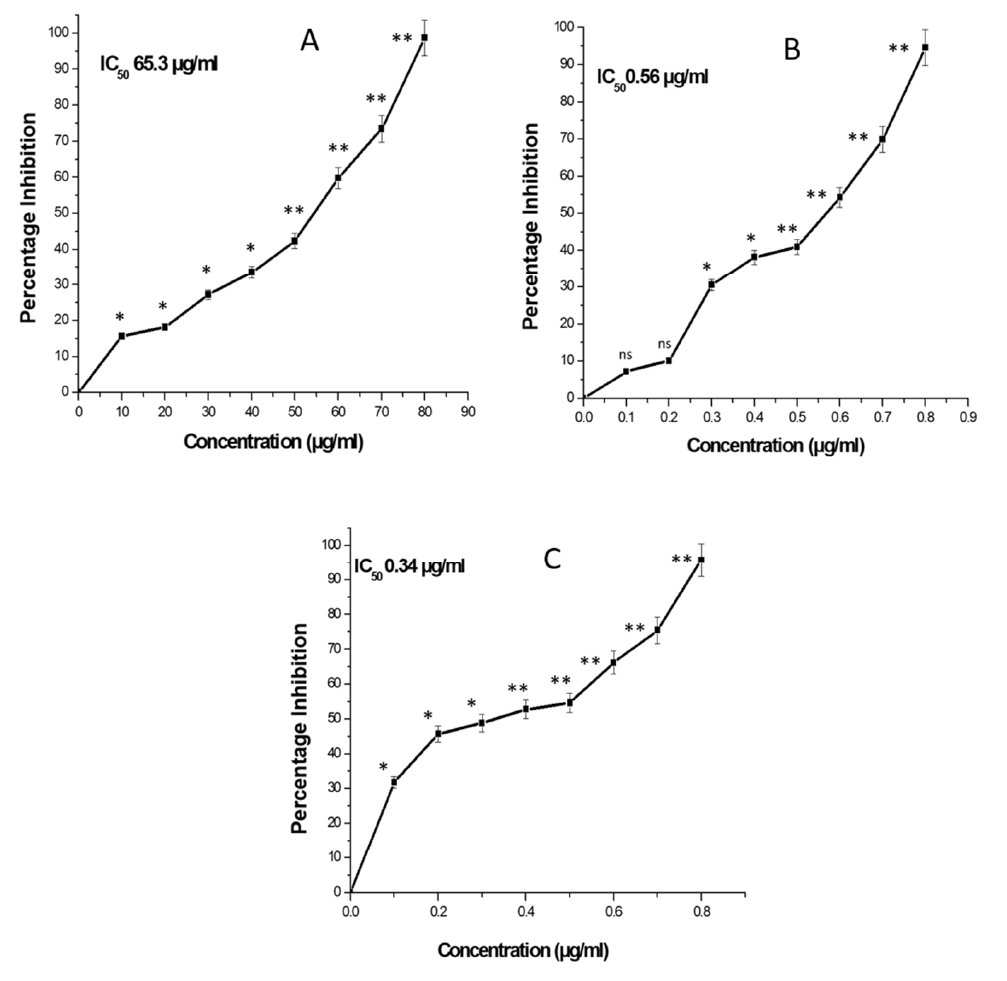
Figure 6. The cytotoxicity study of ( A ) ZnONPs, ( B ) DOX, ( C ) DOX-ZnONPs against A549 cells. Data shown represent mean ± standard error of mean of triplicate experiments repeated thrice. * p < 0.05, and ** p < 0.01 indicate significant differences from vehicle control